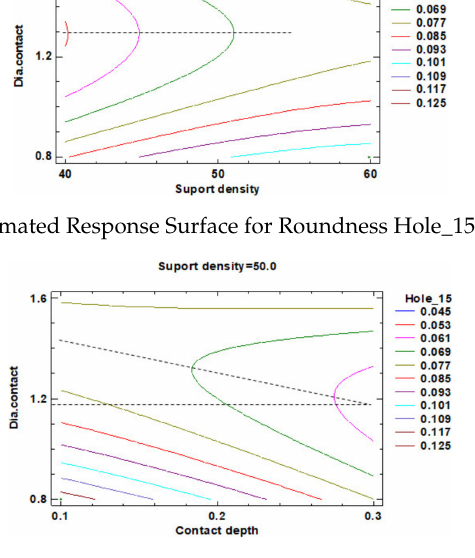
Figure 33. Contours of Estimated Response Surface for Roundness Hole_15 and centre support density.